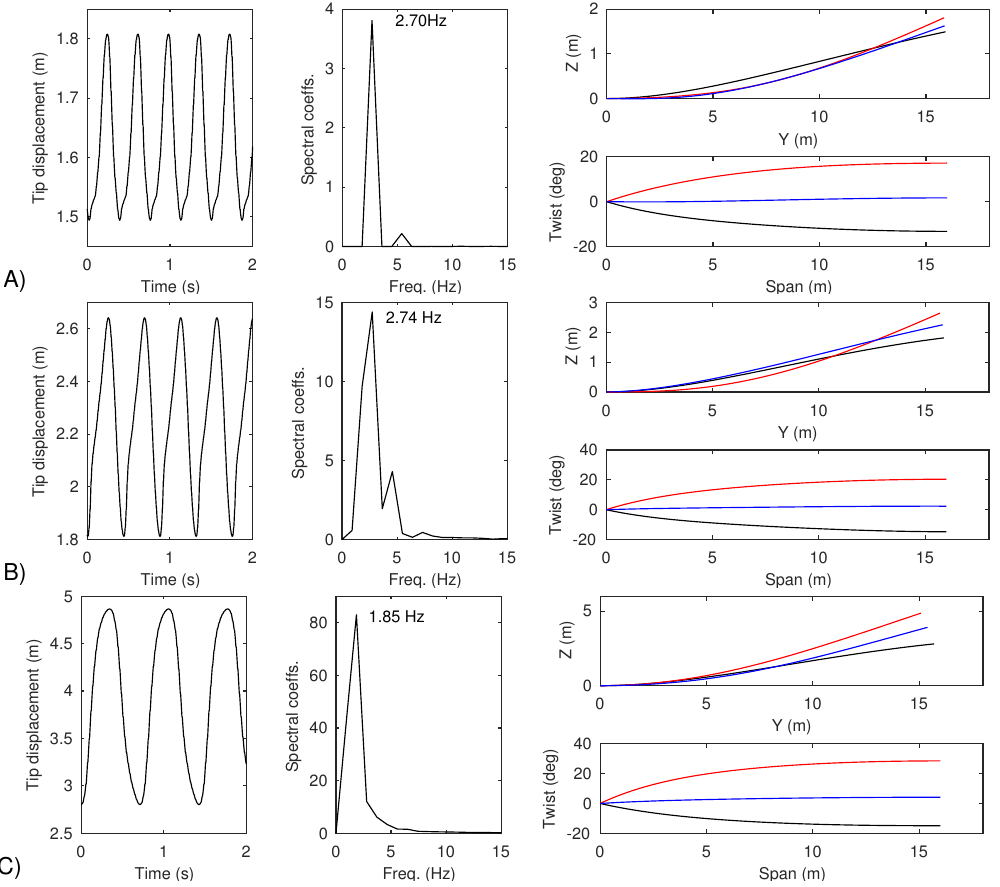
Figure 9. Time history, frequency and spanwise deformation* for LCOs located at points ( A – C ) on Figure 6. * red = max. tip deformation, black = min. tip deformation and blue = mid tip